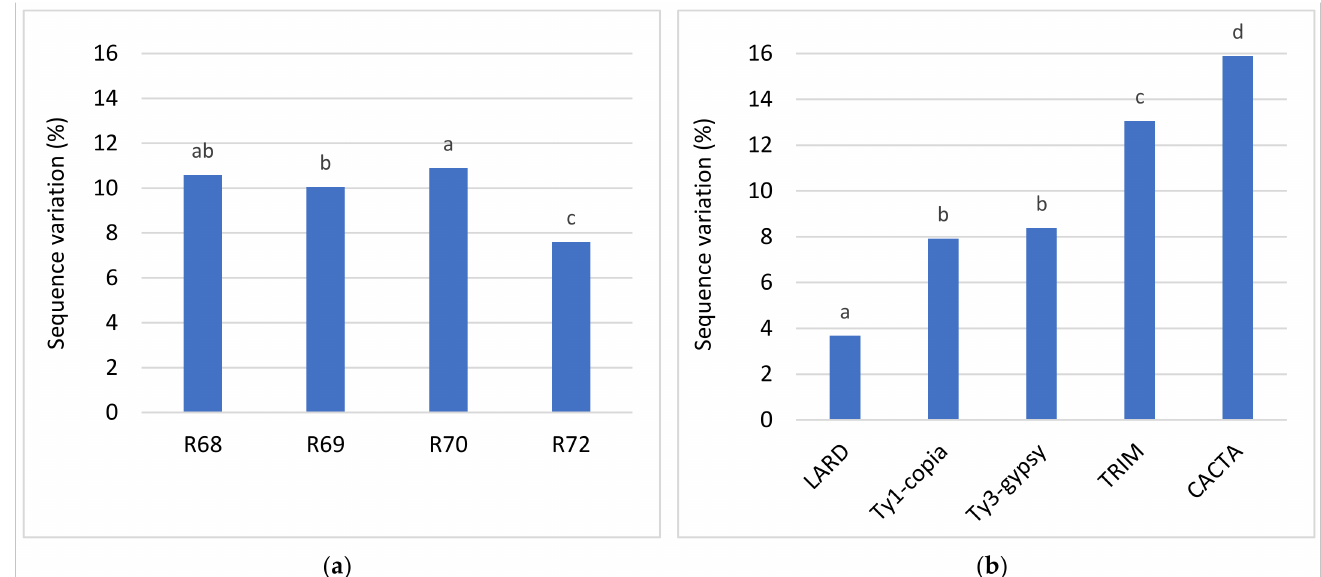
Figure 4. Homogeneous subsets of ( a ) regenerant groups derived from donor plants and ( b ) mobile elements belonging to five TE families based on SV and evaluated using the Ryan–Einot–Gabriel–Welsch Range post hoc tests. R68–R72- regenerants obtained from successive donor plants. Sukkula (LARD), BARE-1 (Ty1- copia ), BAGY-1 (Ty3- gypsy ), Cassandra (TRIM), and Balduin (CACTA)—mobile elements belonging to families of transposable